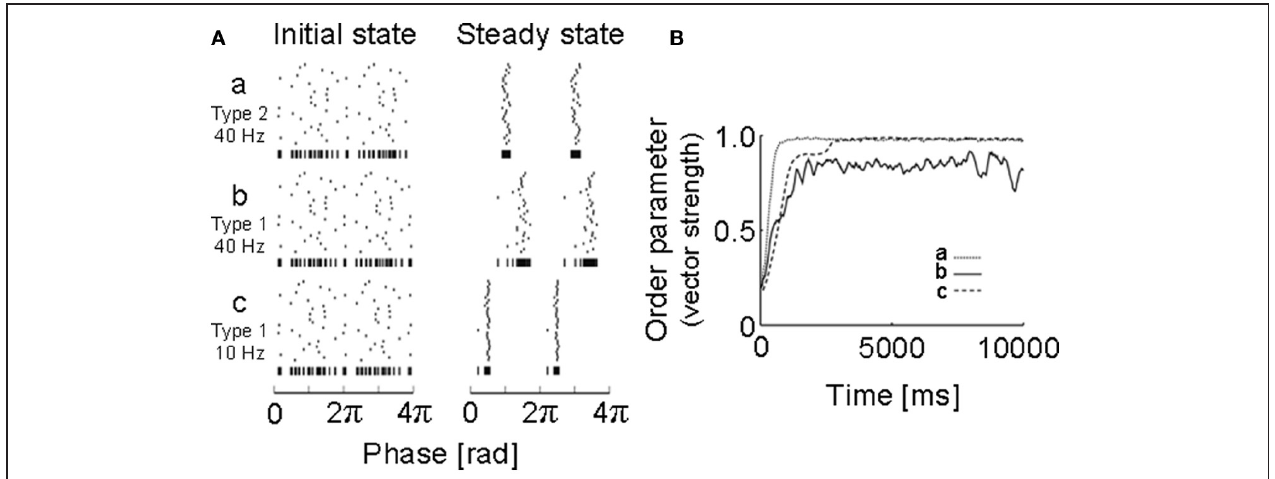
FIGURE 2 | Simulations of neural oscillators coupled witha PRC obtained for a motorcortex neuron.(A) Initial states and steady states were obtained by numerical simulations of 30 neuronal oscillators coupled mutually via fast AMPA synapses: a, 40Hz (type 2); b, 40Hz (type 1); c, 10Hz (type 1). Vertical bars at the bottom of each raster plot represent all spikes of the 30 neurons in